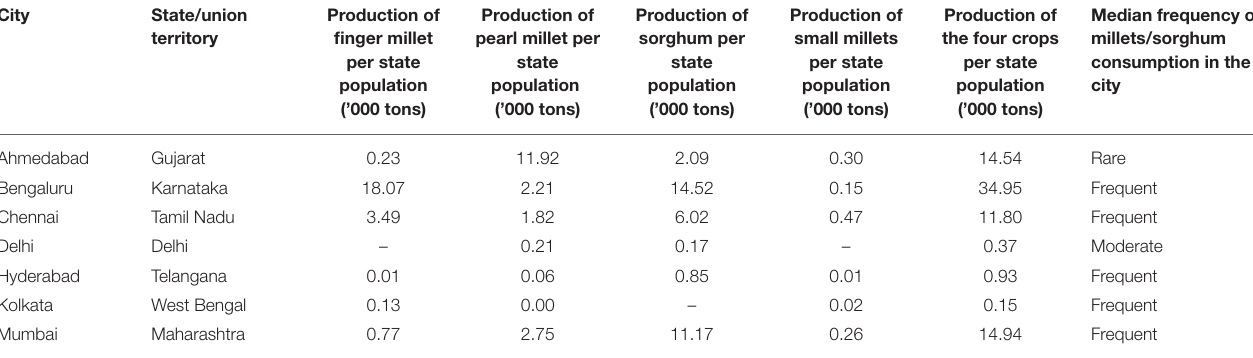
TABLE 7 | Production (tons) of millets and sorghum per state population in 2015–2016 and their frequency of consumption. City